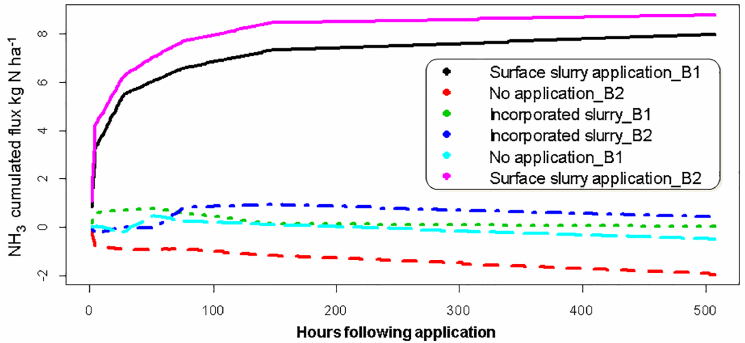
Figure 16. Cumulated fluxes estimated with the inference method on the real test case with strategy C7. Three treatments with two repetitions are compared (B1 and